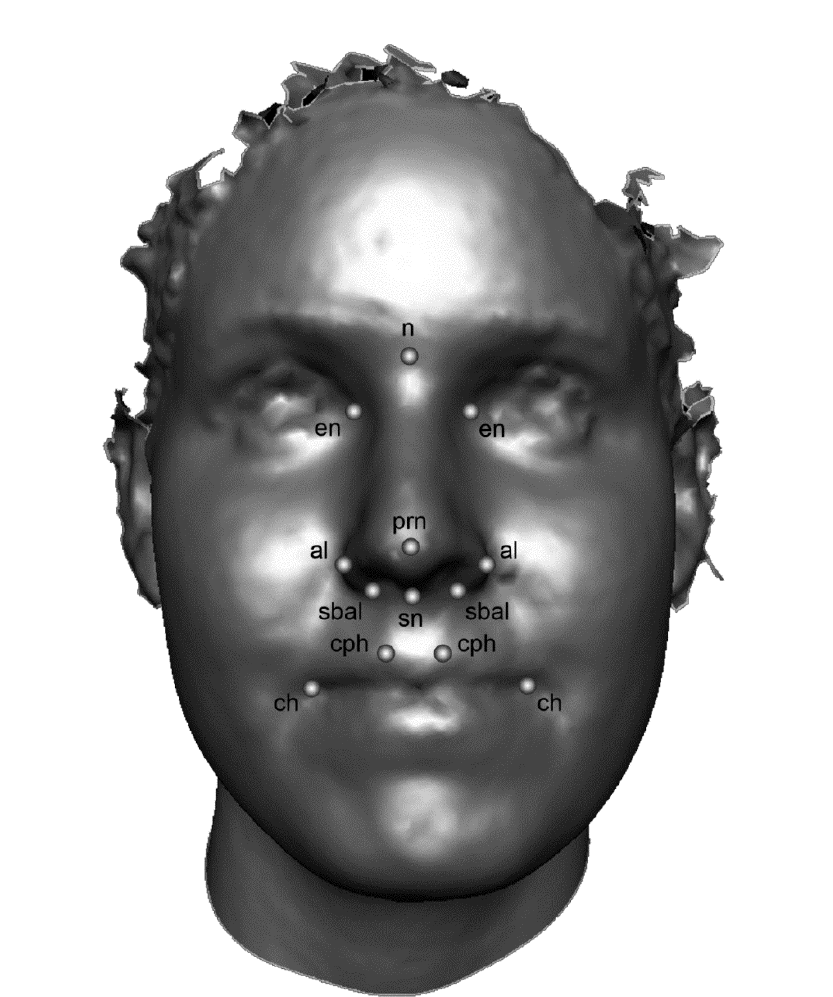
Figure 1. 3D facial surface showing the midfacial landmarks used in the present study. Midline points: n=nasion, prn=pronasale, sn=subnasale. Bilateral points: en=endocanthion, al=alare, sbal=subalare, cph=crista philtri,